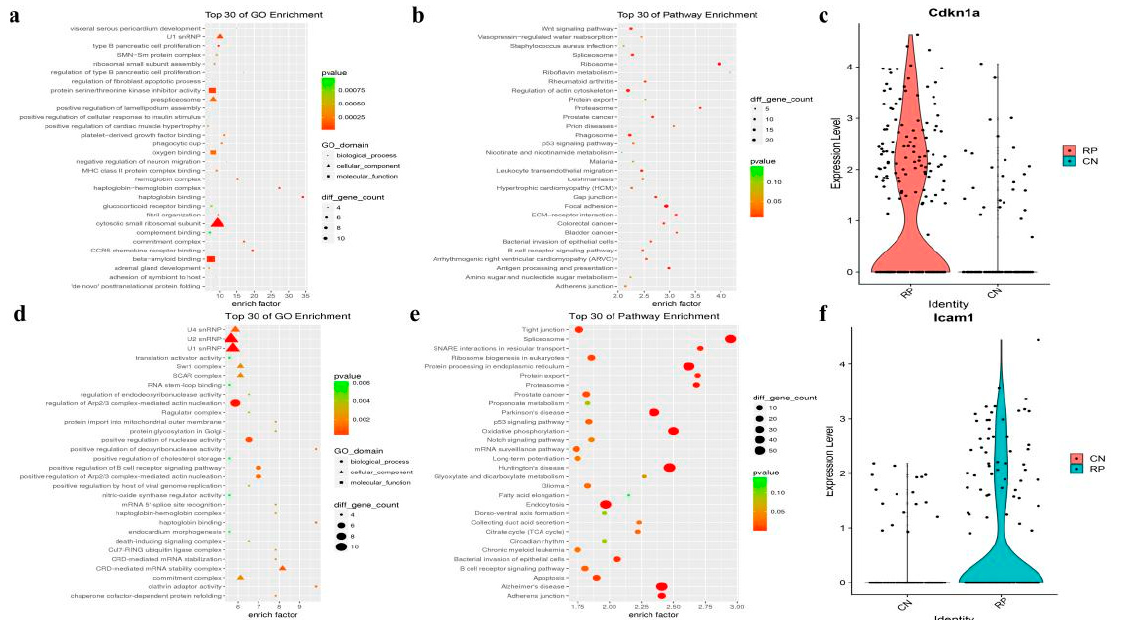
Figure 4. The fibroblasts and vascular endothelial cell markers and pathway analysis. ( a , b ) The GO analysis of up-regulated DEGs shows top30 highlighted pathways in RP fibroblasts cells ( n = 4, hypergeometric test, adjusted p -values obtained by Benjamini-Hochberg procedure). ( c ) Violin plots showing the expression level of representative novel identified markers across the fibroblasts cell types. ( d , e ) Dotplot showing the representative top30 pathway terms of KEGG enriched in vascular endothelial cells (VECs). ( f ) Violin plots showing the expression level of representative novel identified markers Icam1 across the endothelial